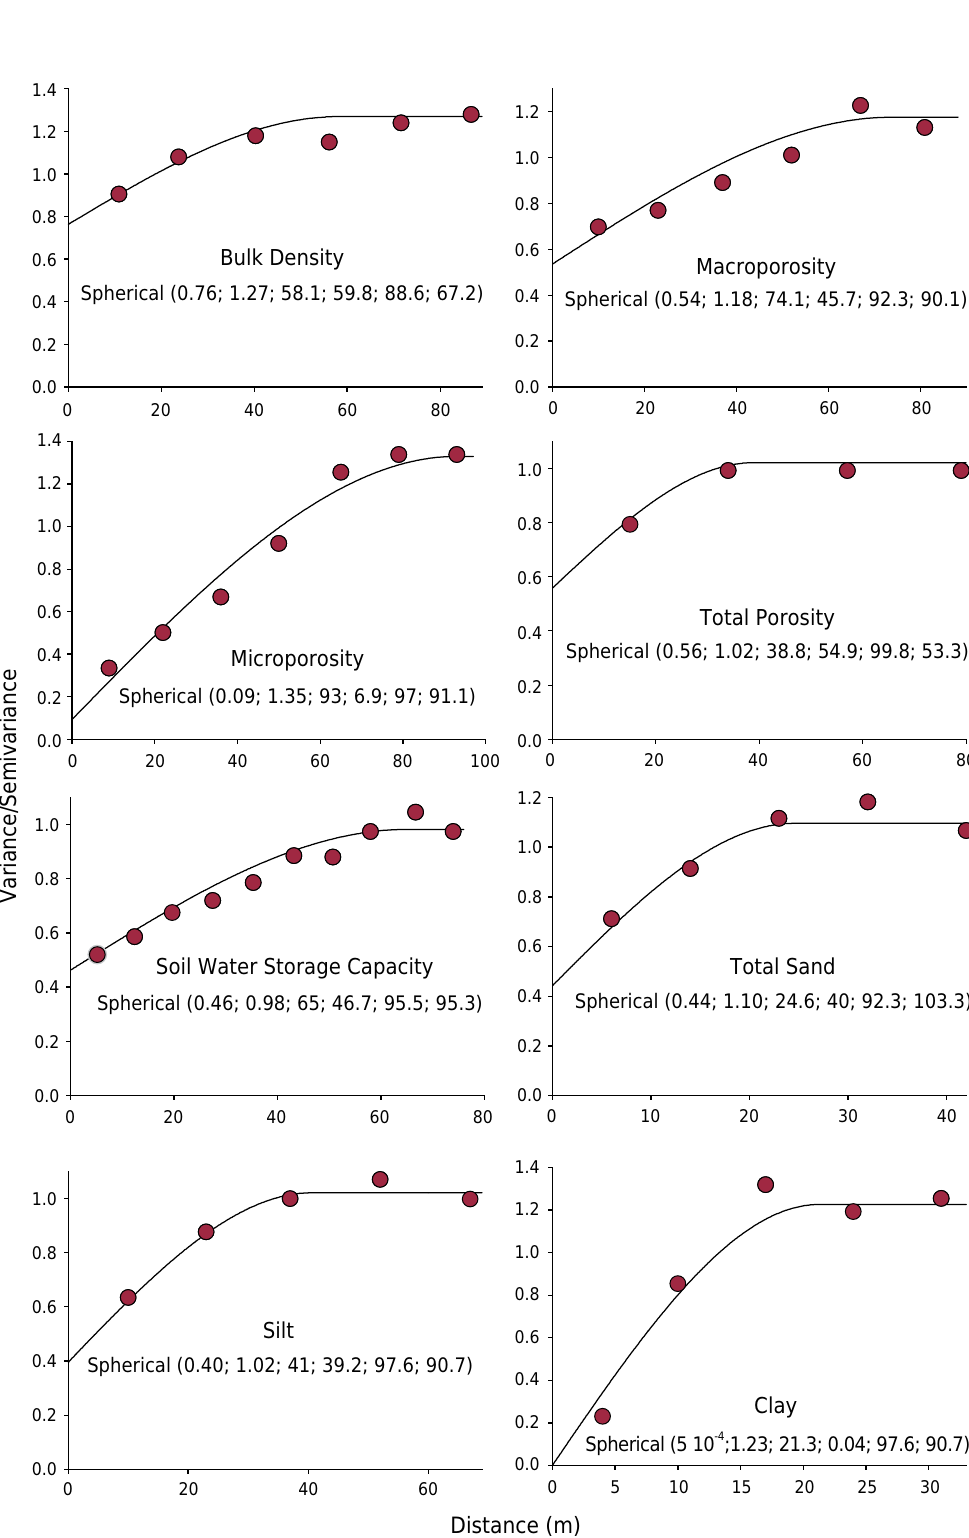
Figure 3. Experimental semivariogram models fitted to soil density, soil macroporosity and microporosity, total porosity, soil water storage capacity, and total sand, silt, and clay in a Conilon coffee field. Values in brackets are nugget effect (C o ), sill (C o +C), range (a), spatial dependence index (SDI), coefficient of determination (R 2 ), and cross-validation regression coefficient (CVRC),